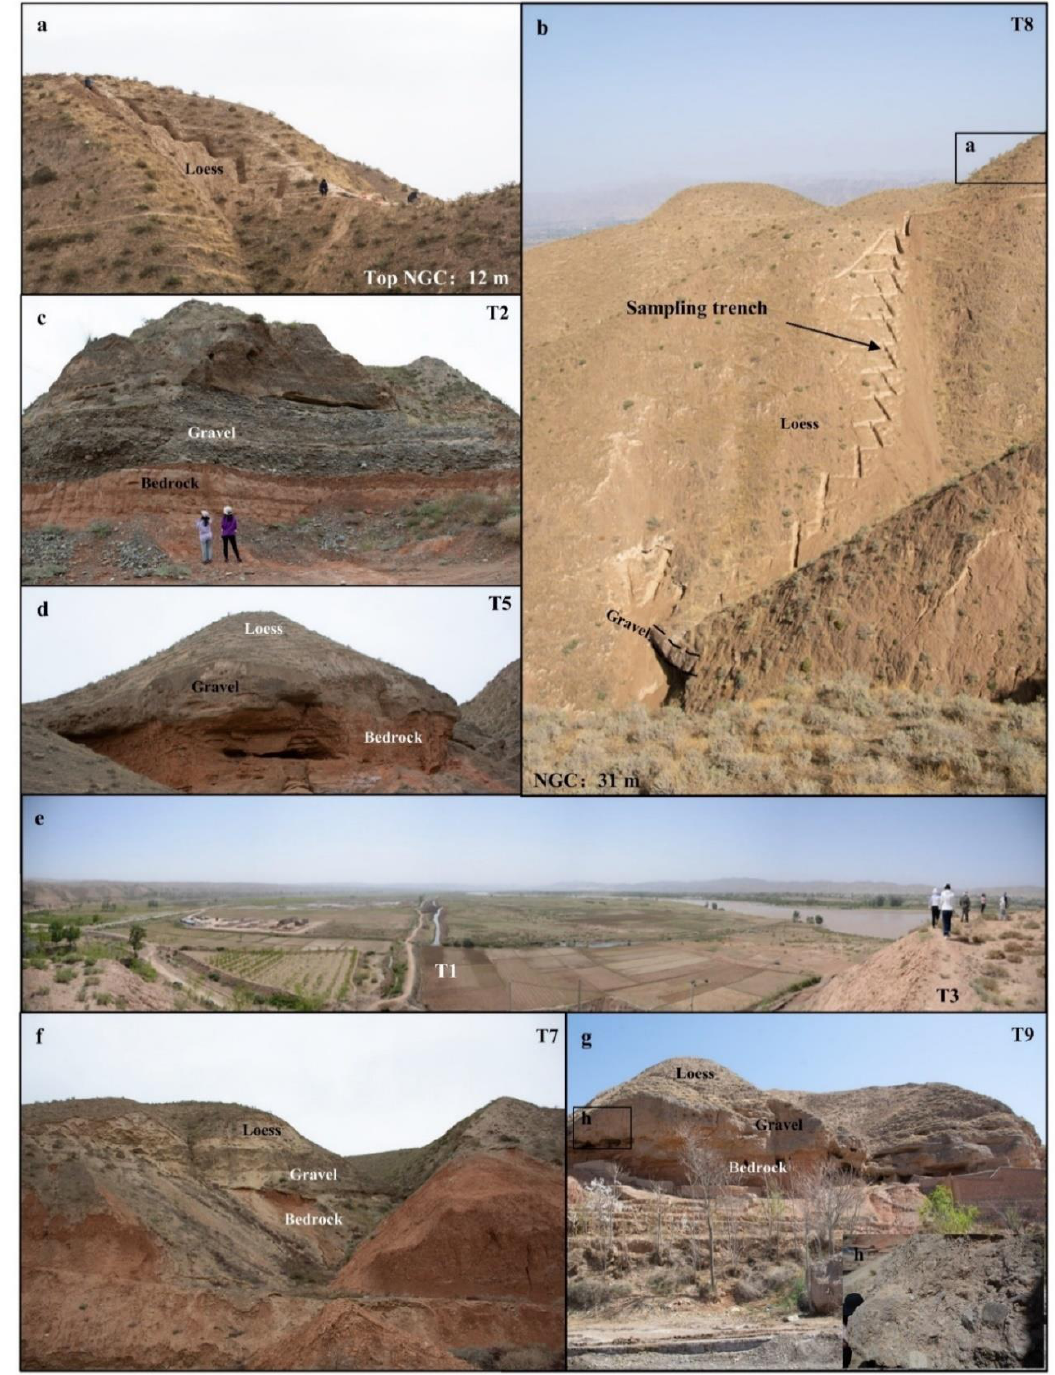
Figure 5. Field photos of each terrace at the NGC section with the sampling trenches of terrace T8. ( b – d , f , g ) are from terraces T8, T2, T5, T7 and T9, respectively. ( e ) the terraces T1 and T3. ( a ) the upper 12 m loess sediment of T8 (Top NGC, see location in ( b )) and ( b ) the lower 31 m of loess and flood sand/silt sediment of T8. The staircase trenches (1–3 m high and 0.5–1 m deep for each one) in ( a , b ) are for sampling powder and paleomagnetic samples. ( h ) the enlarged photo of the gravel layer of terrace T9 (see location in ( g )).